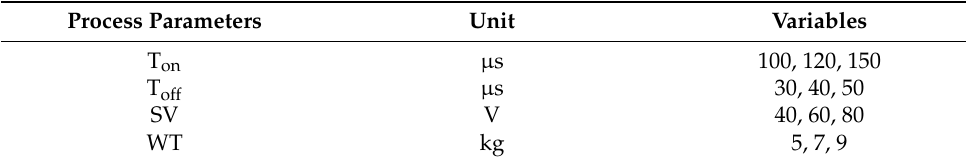
Table 3. Influence of tool electrodes in the WEDM process.